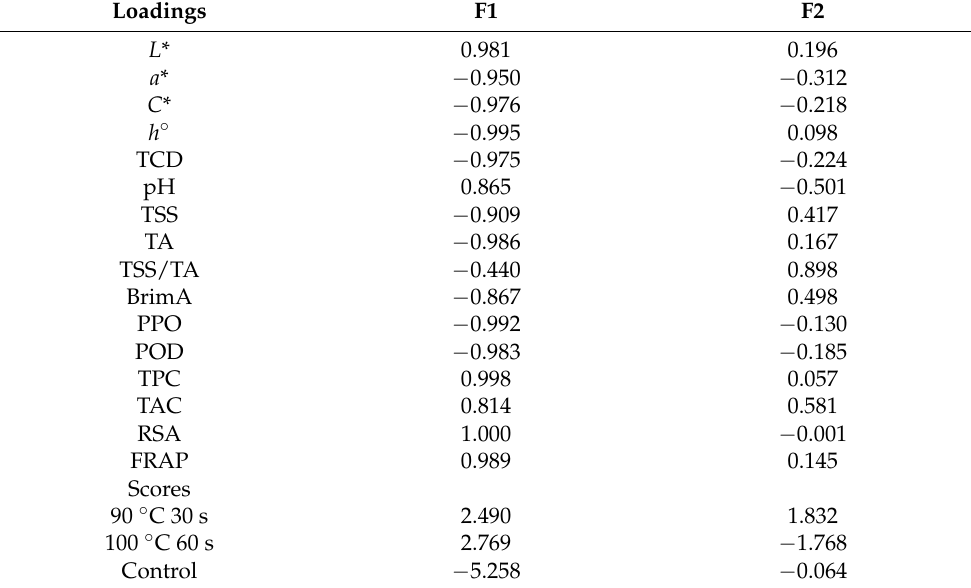
Table 4. Factor loadings and score for the first two principal (F1–F2) components of dried pomegranate arils at different blanching conditions.